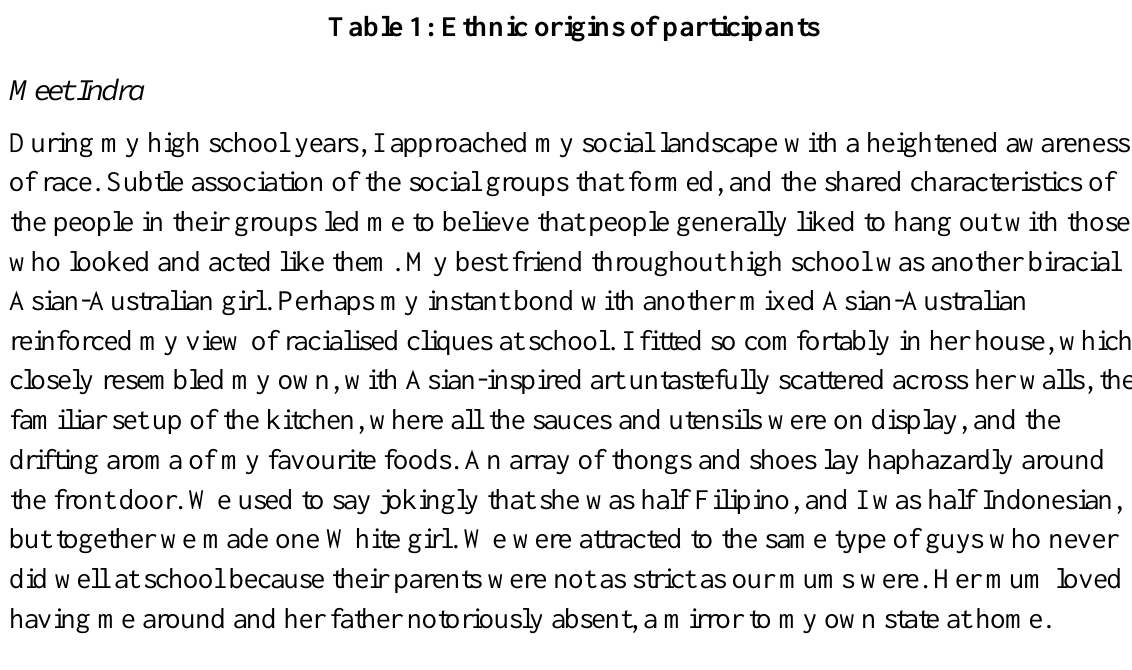
Table 1: Ethnic origins of